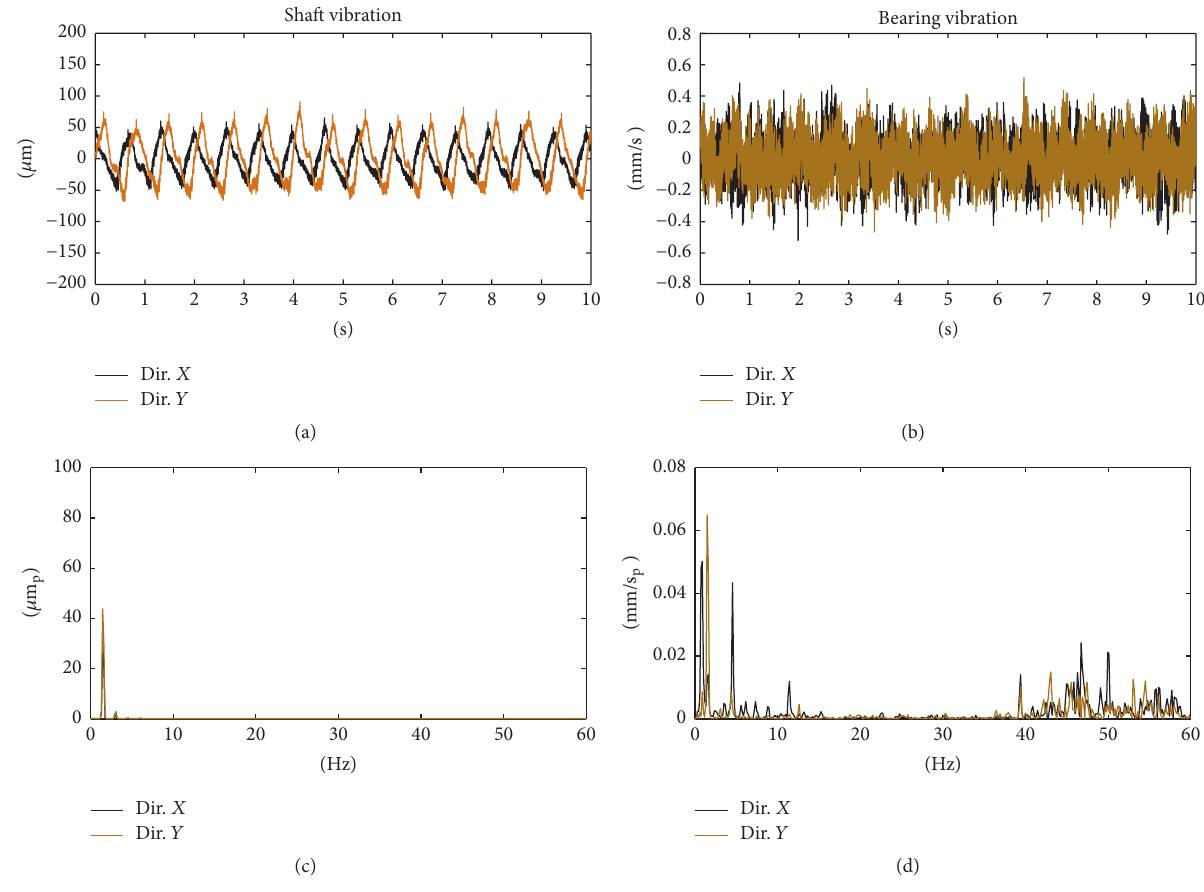
Figure 3: Shaft relative vibrations ((a) and (c)) and bearing absolute vibrations ((b) and (d)), in 𝑋 -direction and 𝑌 -direction, in time domain ((a) and (b)) and in frequency domain ((c) and (d)), measured at the UJB of a LHG operating with 617MW (01.14.10).